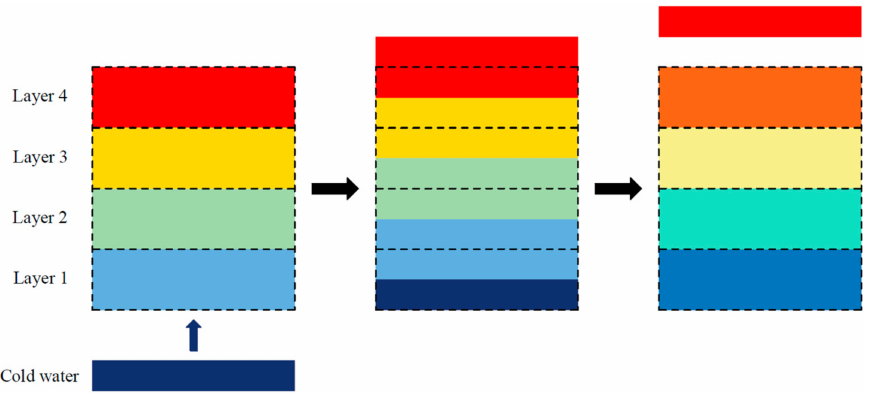
Figure 6. Graphical representation of the withdrawn volume (“piston movement”).